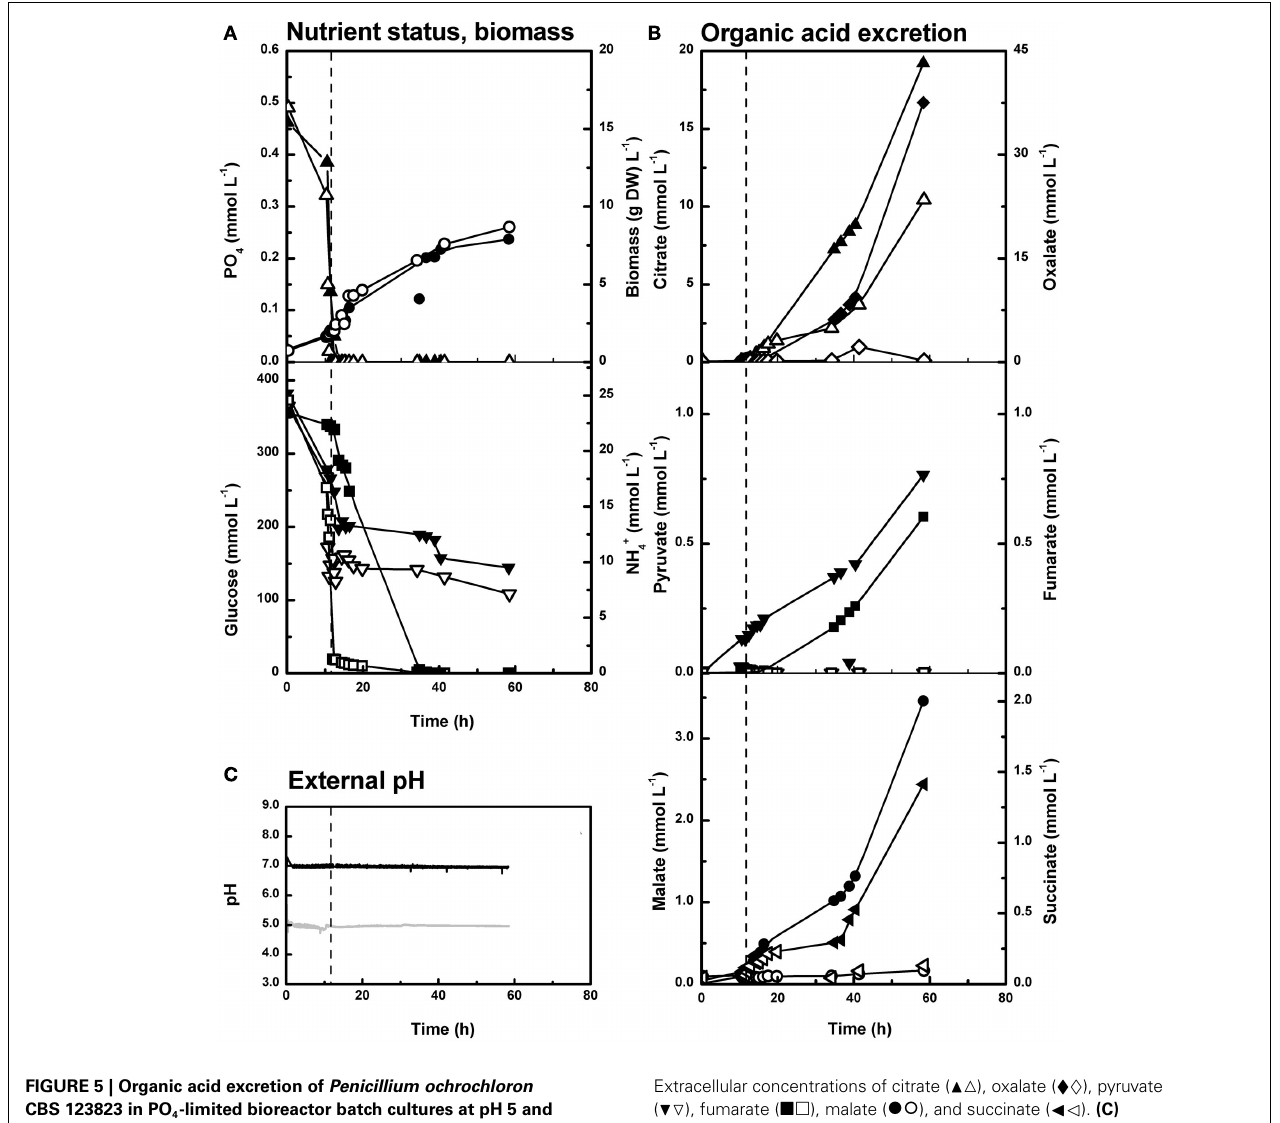
Extracellular concentrations of citrate ( (cid:2) (cid:4) ), oxalate ( (cid:3)♦ ), pyruvate •◦ ( (cid:7)(cid:8) ), fumarate ( (cid:6)(cid:4) ), malate ( ), and succinate ( (cid:10)(cid:5) ). (C) External pH. Representative experiments are shown. Average of three independent experiments from one specific time point of cultivation is depicted in Figure 3 (pH 5 at 42.2 ± 0.48h and pH 7 at 41.4 ± 0.57h of